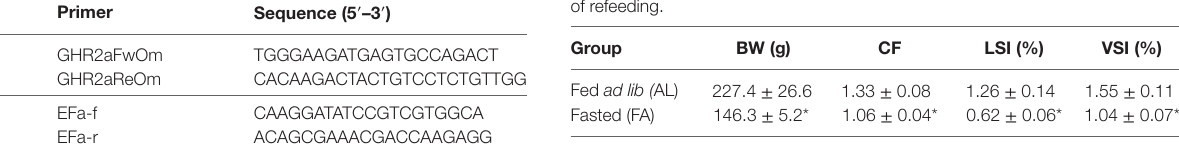
TaBle 2 | Body weight (BW), condition factor (CF), liver somatic index (LSI), and visceral somatic index (VSI) of rainbow trout fed ad lib (AL group; n = 6)